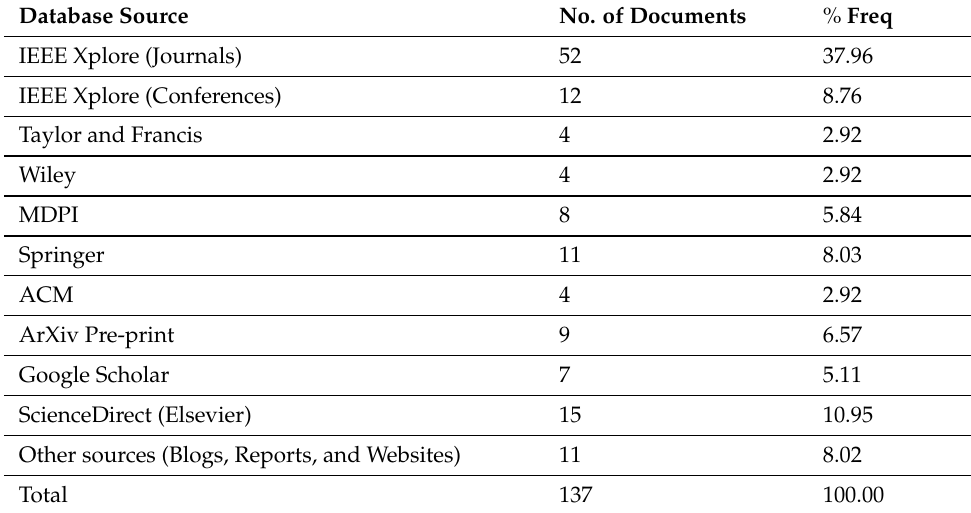
Table 2. Publications used in this review.